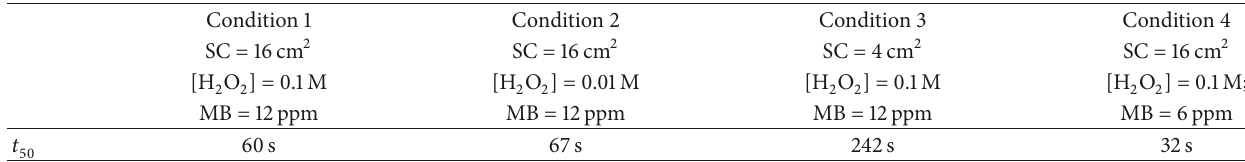
Table 1: The experimental conditions used in the reaction order study of MB discoloration. The variables were spent cathode (SC) area and H 2 O 2 and MB